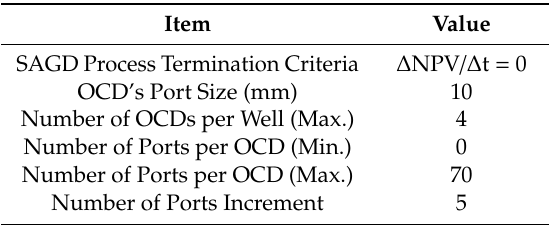
Table 1. Fixed parameters in the optimization